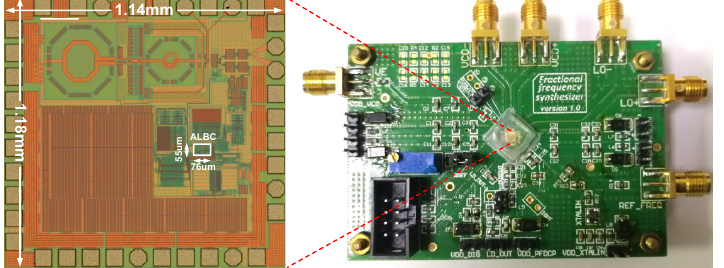
Figure 12. Chip micrograph and printed circuit board (PCB) test bench of the frequency synthesizer.